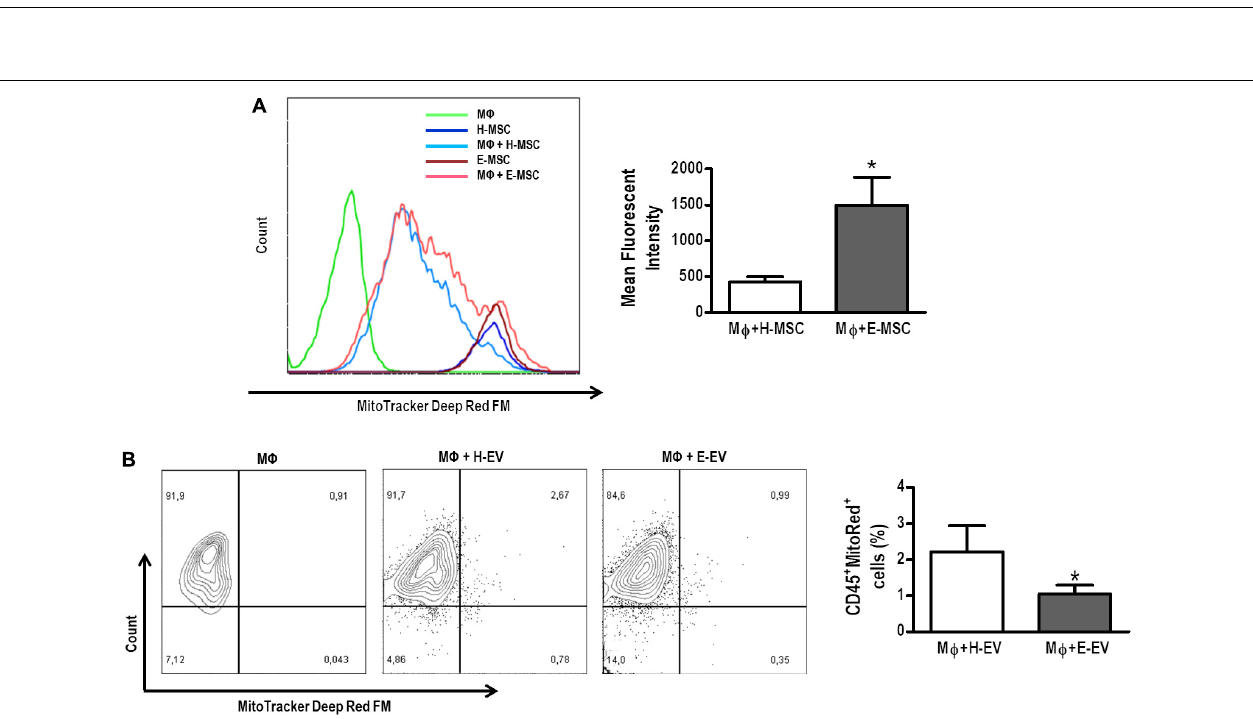
FIGURE 5 | Mitochondrial transfer from healthy or emphysematous MSCs and EVs to alveolar macrophages (M (cid:56) ). (A) Intensity of MitoRed fluorescence of healthy (H) or emphysematous (E) MSCs decreased after direct co-culture with M (cid:56) (light blue and pink histograms, respectively). The extent of mitochondrial transfer to M (cid:56) was measured by flow cytometry. Co-culture of M (cid:56) with MitoRed-pretreated H-MSCs and E-MSCs resulted in increased MitoRed (APC + ) mean fluorescent intensity of M (cid:56) . (B) Scatter plots show M (cid:56) and EV after 24 h in co-culture. The presence of CD45 + M (cid:56) , demonstrating acquisition of MitoRed fluorescence (APC + ), indicates that mitochondrial transfer occurs from H-EVs and E-EVs. Data are representative of three independent experiments. The histograms represented graphically in (A) are from a single representative experiment. * P < 0.05 vs. the M (cid:56) + H-MSC.